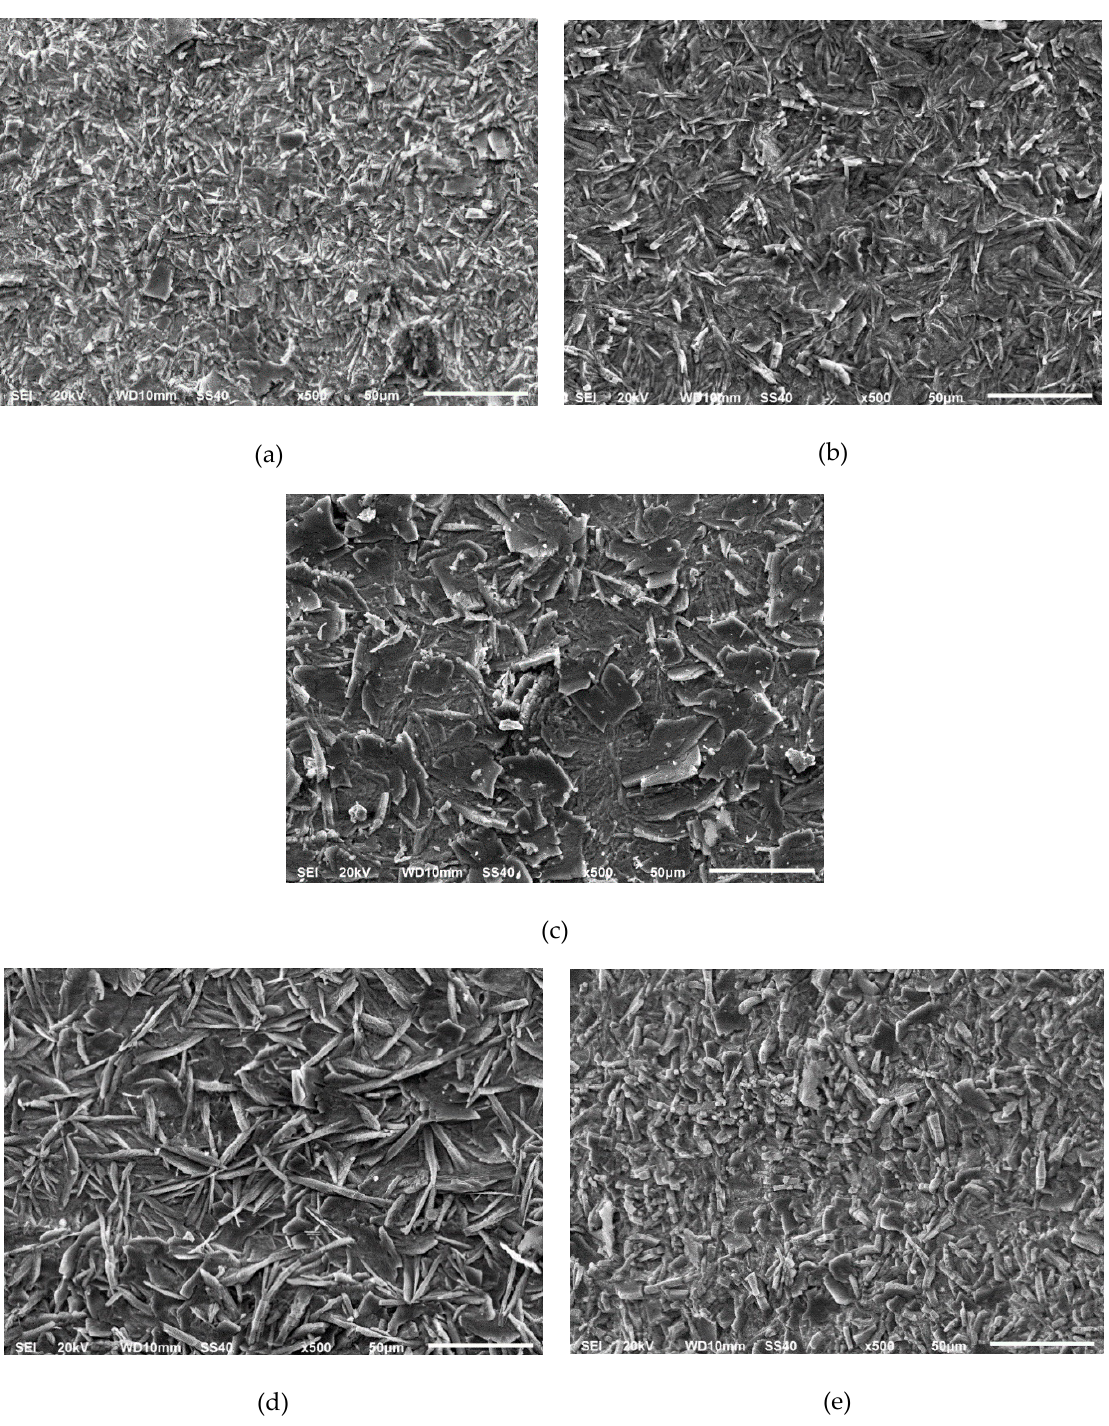
Figure 1. SEM images of the phosphate layers prepared after the several pickling conditions: ( a ) H 2 SO 4 196.2 g/L; ( b ) H 2 SO 4 98.1 g/L; ( c ) HCl 72.9 g/L; ( d ) H 3 PO 4 196.2 g/L at ambient temperature; ( e ) H 3 PO 4 196.2 g/L at 50 °C.